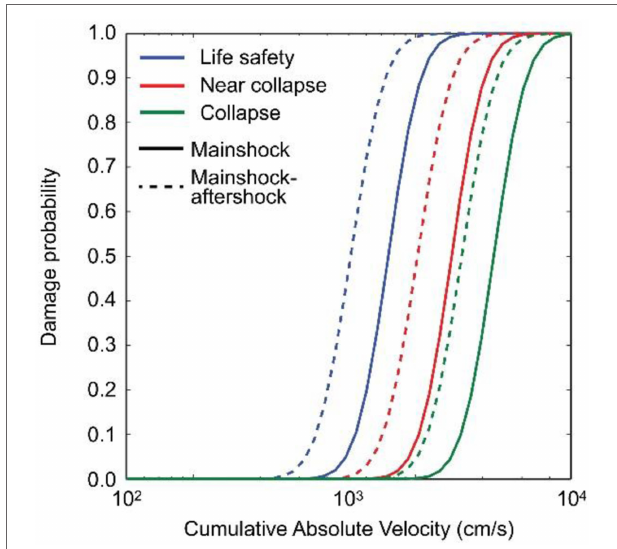
FIGURE 9 | CAV- D MD, C fragility models for MS and mainshock– aftershock records based on the damage index thresholds listed in Tables 2 and 3 . D MD, C is calculated based on Eq. 5 with c = 1.